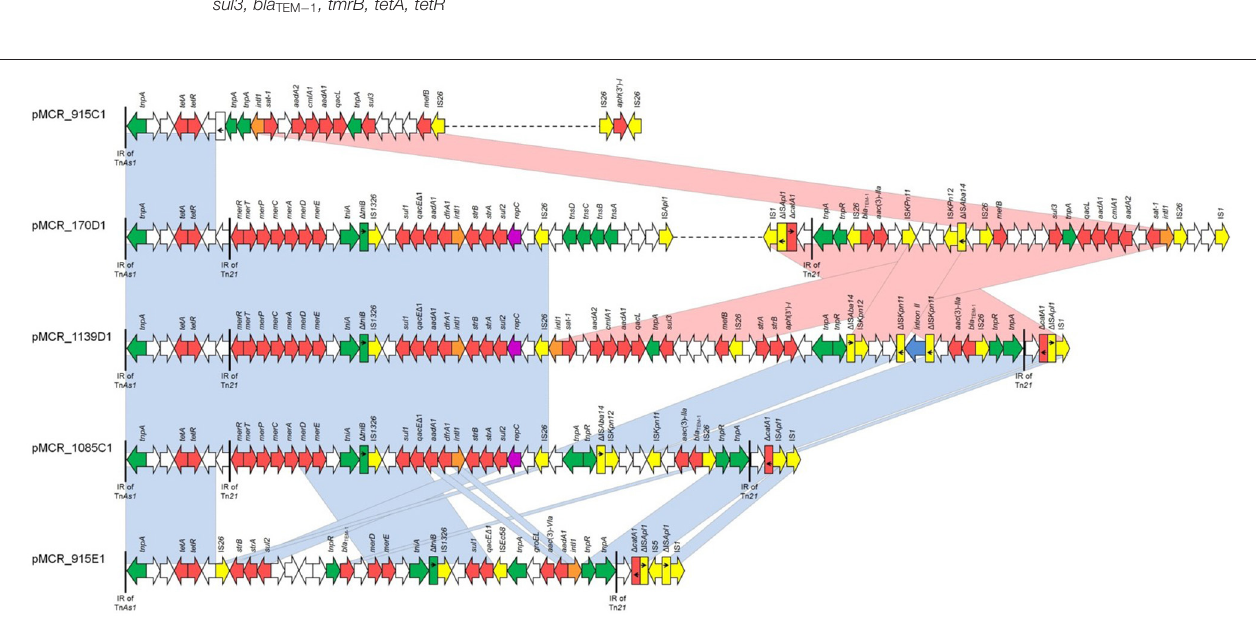
FIGURE 4 | Linear maps of the multidrug resistance regions of IncHI2 plasmids, carrying mcr-1.1 genes. Arrows show the direction of transcription of open reading frames (ORFs), while truncated ORFs appear as rectangles (arrows within rectangles indicate the direction of transcription). Antimicrobial resistance genes are shown in red. IS elements and transposases are shown in yellow and green, respectively. intI1 genes are shaded orange. The remaining genes are shown in white. Homologous segments (representing ≥ 99% sequence identity) are indicated by light blue shading, while pink shading shows inverted homologous